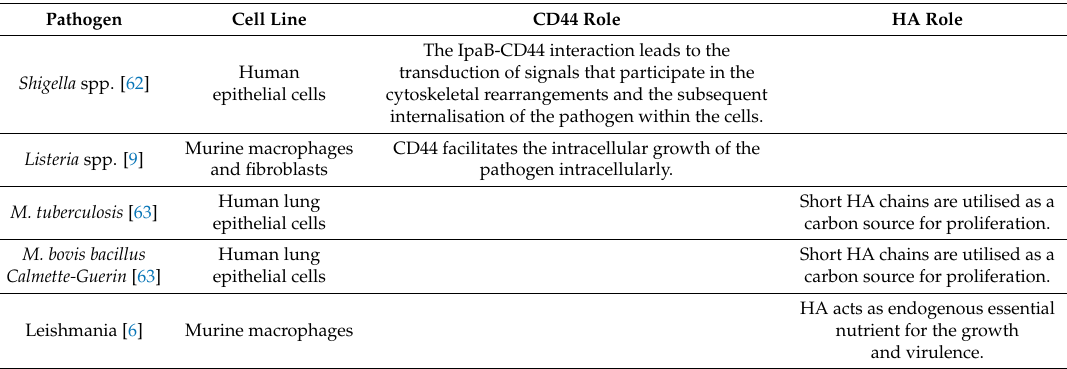
Short HA chains are utilised as a carbon source for